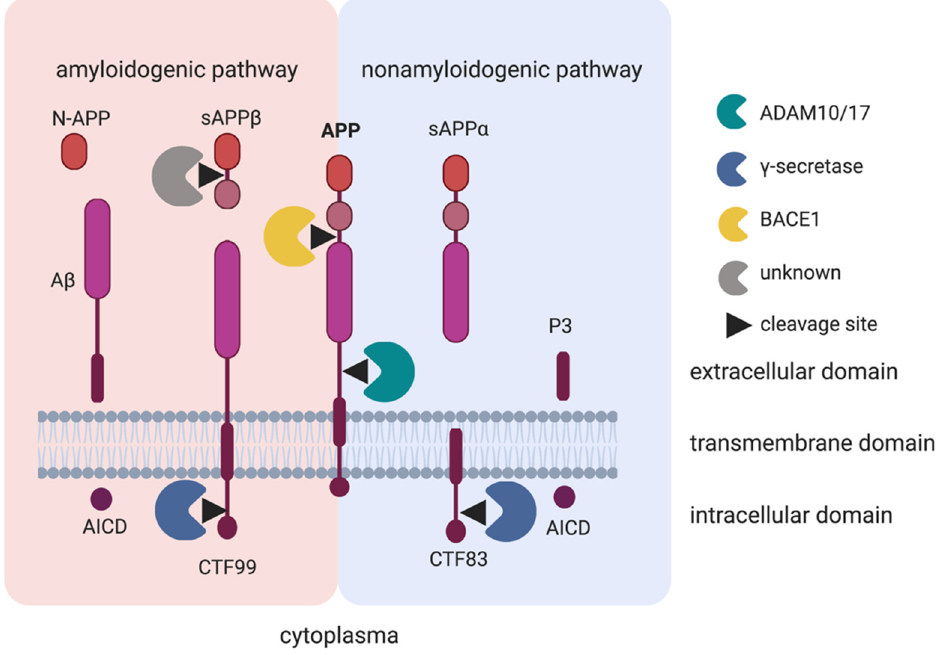
Figure 2. Overview of cleavage products of the Amyloid Precursor Protein (APP) by different secre- tases. The cleavage of APP by the β -site APP cleaving enzyme 1 (BACE1) initiates the amyloidogenic pathway, where the soluble fraction of APP (sAPP) β and C-Terminal Fragment 99 (CTF99) are created. γ -secretases further process the CTF99 to create the neurotoxic A β protein and the Amyloid Precursor Intracellular Domain (AICD). Meantime, sAPP β is also cleaved by additional secretases at an unknown site to generate an N-terminal of APP (N-APP). The cleavage of APP by either ADAM10 or ADAM17 initiates the nonamyloidogenic pathway, which creates sAPP α and C-Terminal Fragment 83 (CTF83). γ -secretases then cleave CTF83 to create P3 and AICD.